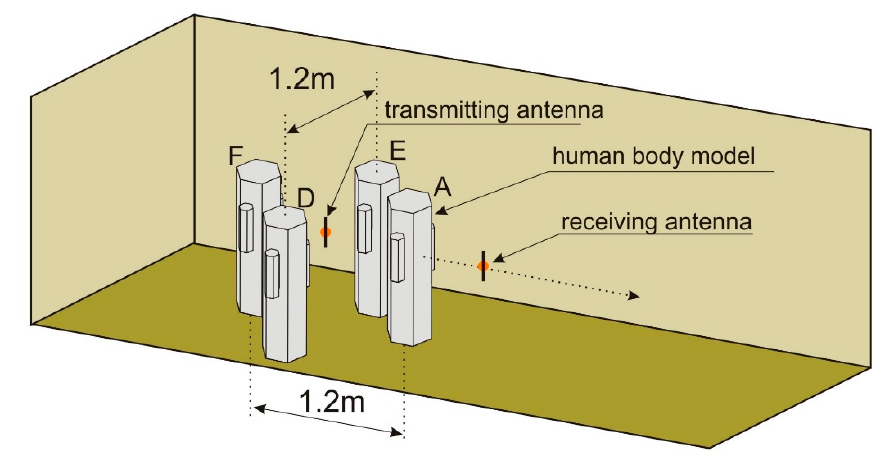
Figure 11. Geometry of the second scenario for simulating the shadowing effect in XGtd™.